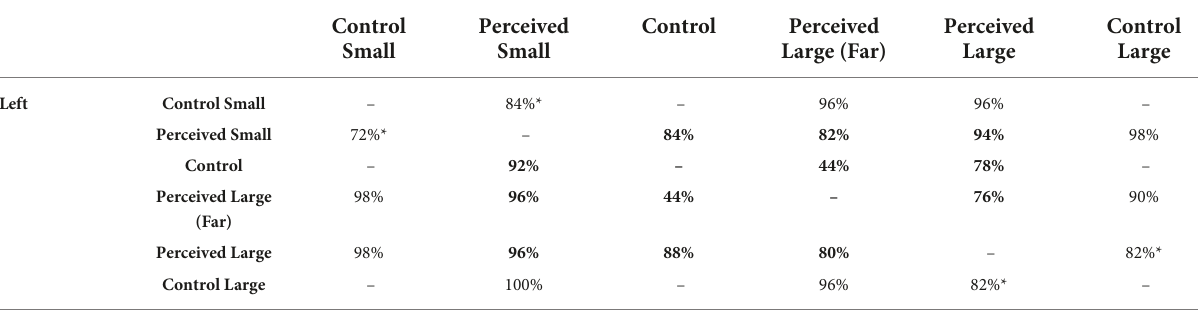
TABLE 6 Experiment 2 perceptual